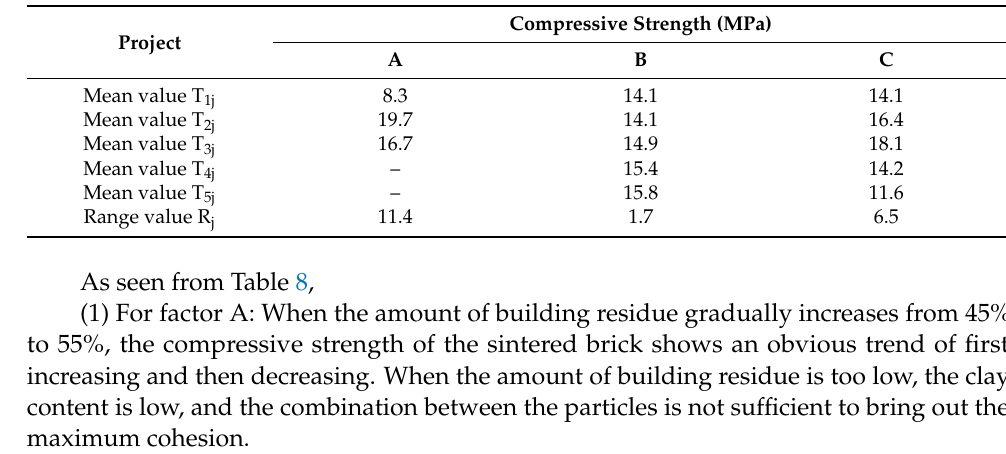
Table 8. Range analysis of influence of various factors on compressive